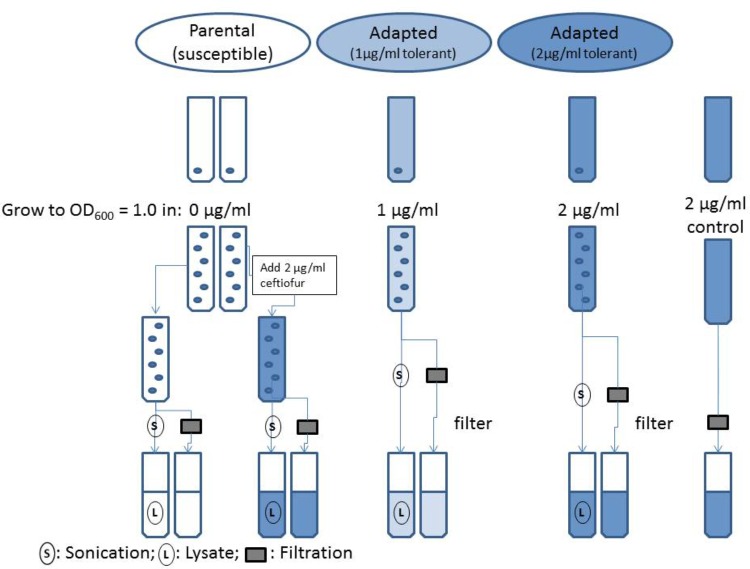
Flowchart of evaluation of ceftiofur localization in ceftiofur susceptible and tolerant cultures.